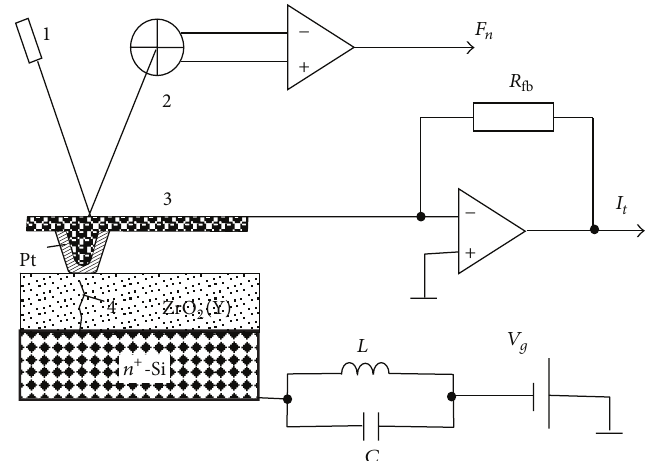
Figure 1: The schematic representation of the experiment on the investigation of the resistive switching effect in the YSZ/ n + -Si films by Conductive Atomic Force Microscopy. 1—AFM laser; 2—quadrant photodetector; 3—Pt-coated cantilever; 4—filament.